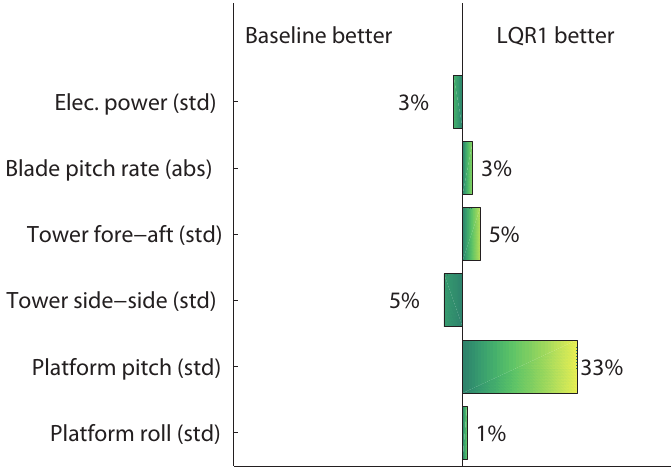
Figure 9. Aligned wind-wave forces with a peak wave period of 10 s: statistical analysis of relative controller performance with respect to the mean and standard deviation